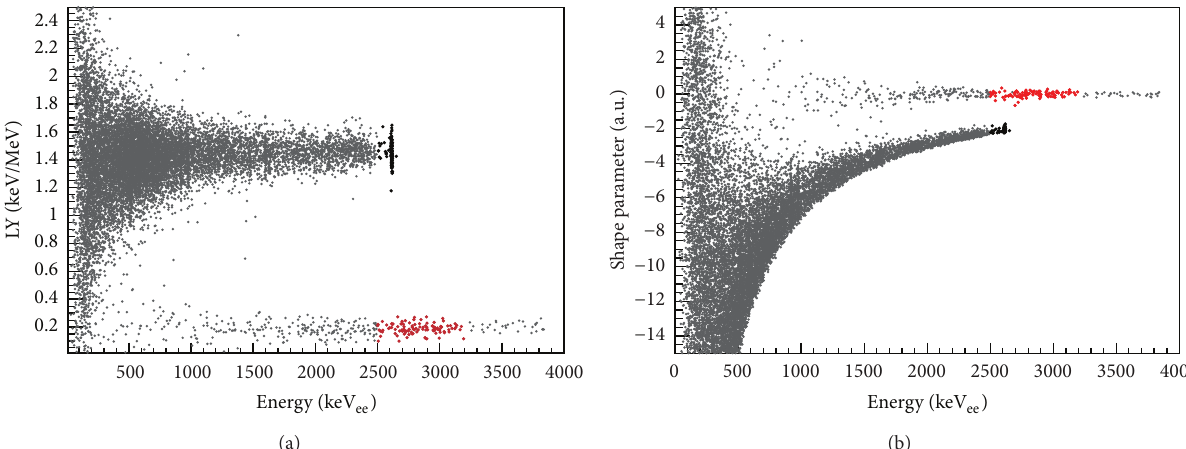
Figure 6: Particle discrimination in ZnMoO 4 obtained in a calibration run with a 228 Th 𝛾 -source and a smeared 𝛼 source. In (a), the LY is reported as a function of the 𝛾 calibrated heat energy. In (b), the shape of the heat pulses is plotted as a function of the energy, using the same events reported in